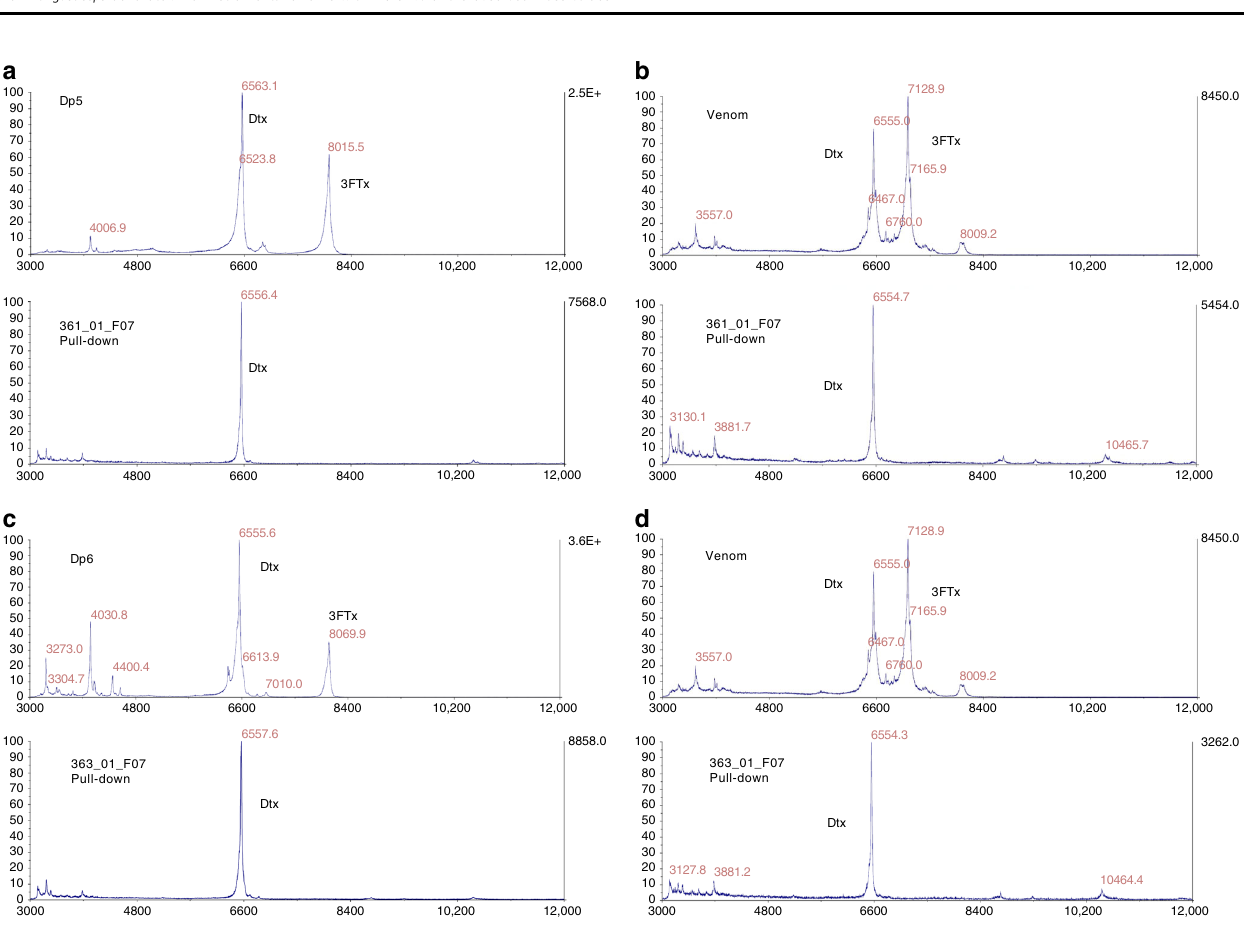
Fig. 3 Example of MALDI-TOF MS analysis of antigen-antibody complex pull-down experiments. a IgG 361_01_F07 pull-down from venom fraction Dp5. b IgG 361_01_F07 pull-down from whole venom. c IgG 363_01_F07 pull-down from venom fraction Dp6. d IgG 363_01_F07 pull-down from whole venom. Dtx Dendrotoxin, 3FTx Three- fi nger toxin